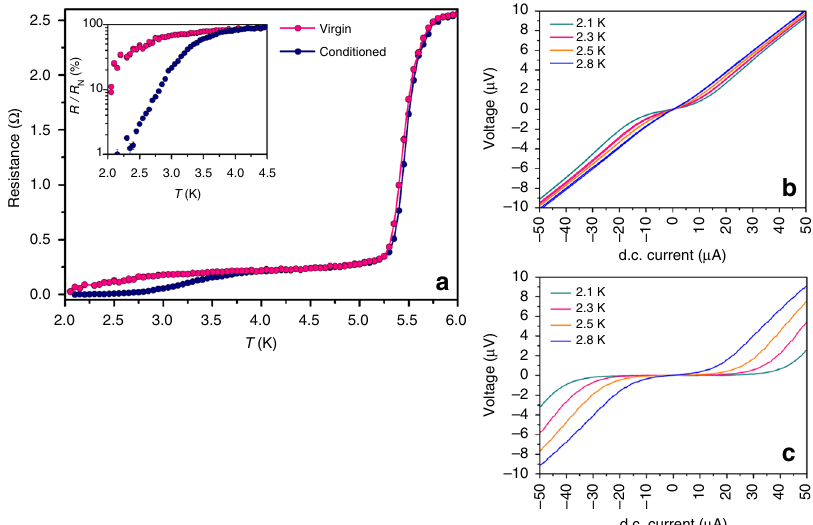
Fig. 3 Junction transport in the virgin and conditioned states. a Resistance as a function of temperature, measured using 10 μ A, before (pink) and after (navy) conditioning the sample. Each set shows two distinct transitions. At T = 5.5 K, the Nb electrodes become superconducting, while the junction is still in the normal state ( R N ≈ 240 m Ω ). Upon cooling further, resistance undergoes a second transition as the barrier begins to proximize by triplet correlations — eventually reaching zero resistance. For clarity, the R − T dependence at lower temperatures is plotted on a logarithmic scale in the inset. While the superconducting electrodes are unaffected by conditioning the ferromagnets, we observe substantial enhancement of superconductivity in the barrier. b , c I − V traces taken at several temperatures before and after conditioning the sample, respectively. The pronounced contrast between the two sets indicates that transport depends strongly on the magnetic con fi guration of the